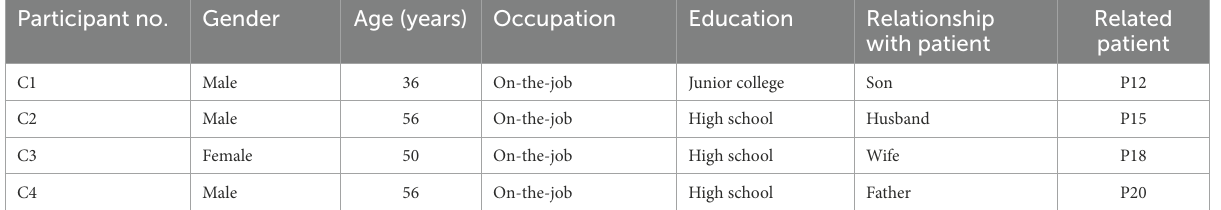
TABLE 3 Patient caregiver (C) information ( n = 4). Participant